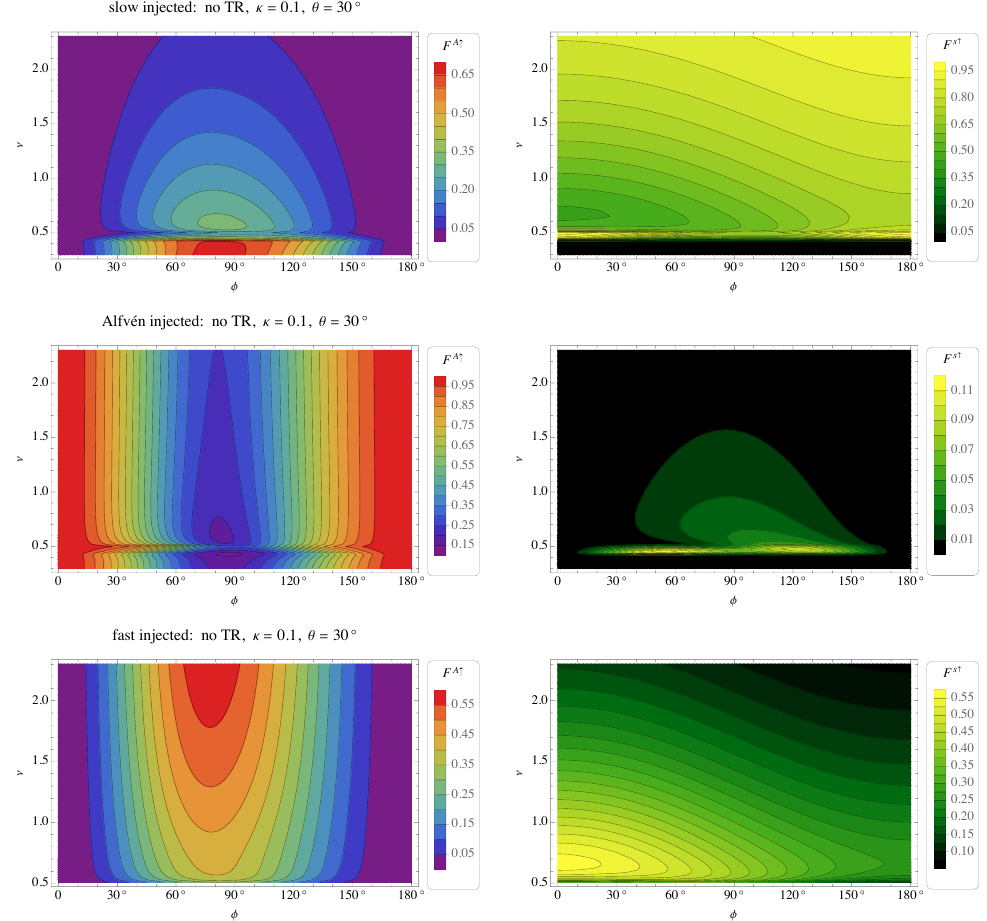
Figure 3. Same as Figure 2, but for θ = 30 ◦